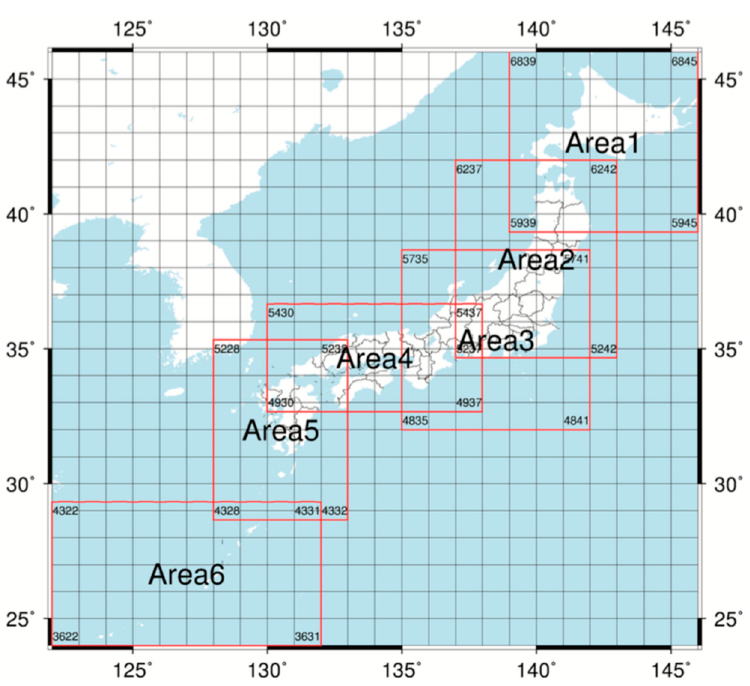
Figure 1. Coverage of six areas in AmGSD. Reproduced with permission from H. Ohno, User’s manual of the Agro-Meteorological Grid Square Data; NARO/CRARC, 2014 [1].